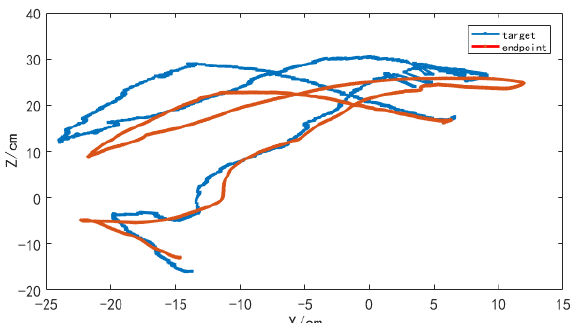
Figure 8. The moving trajectory of target and endpoint of